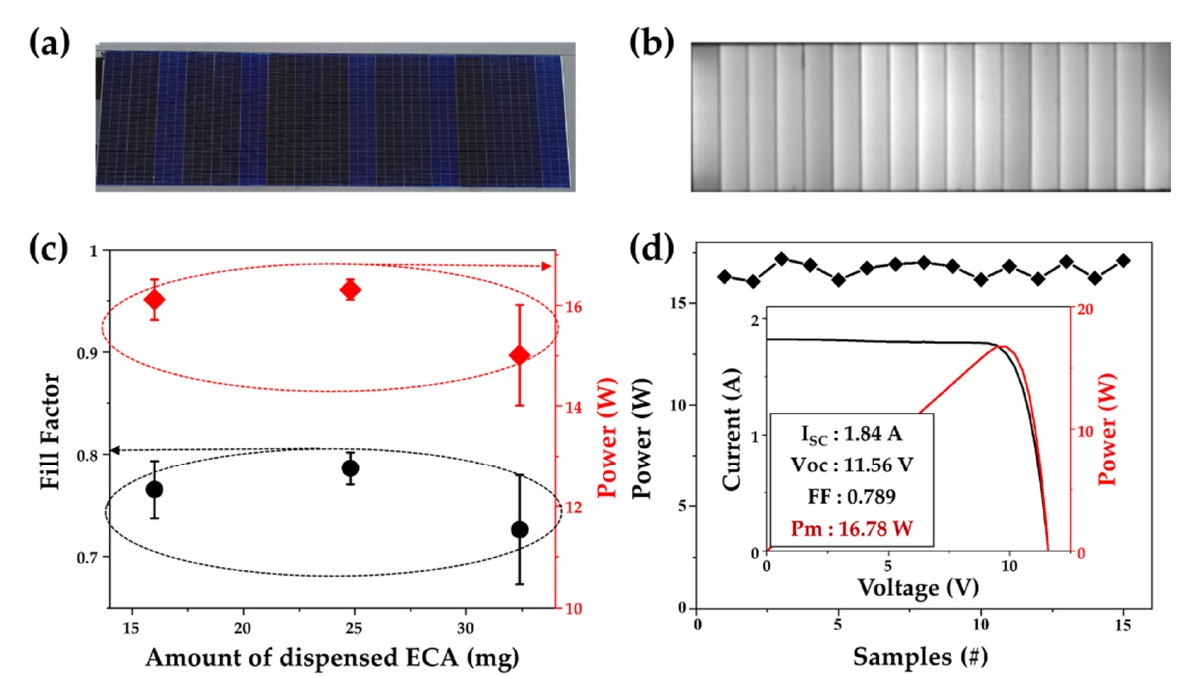
Figure 4. ( a ) Photographic and ( b ) electroluminescence images of shingled-type strings. ( c ) Fill factors and conversion powers with varying amounts of dispensed ECA. ( d ) P M distribution of 15 shingled-type strings. Inset: I-V curve of a shingled-type string.